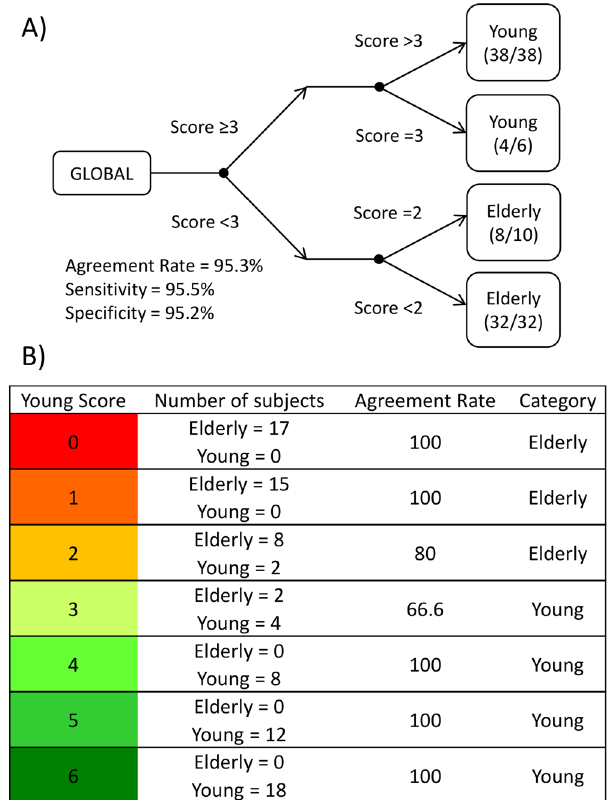
Figure 4. Global decision tree. Section A shows a decision tree that integrates individual variables. Each participant scores 1 point if he/she is classified as young in the decision trees for one variable (distal skin temperature, light exposure, environmental temperature, activity, body position and the integrated variable TAP) and 0 when he/she is classified as aged. The global rate of agreement, sensitivity (test’s ability to correctly detect young subjects) and specificity (test’s ability to correctly detect elderly subjects) are shown below the start of the tree (GLOBAL). When a subject scores three or more points, he/she is classified as young; otherwise he/ she is denoted as aged. Section B shows the agreement rate, classification category and number of subjects for each age group and